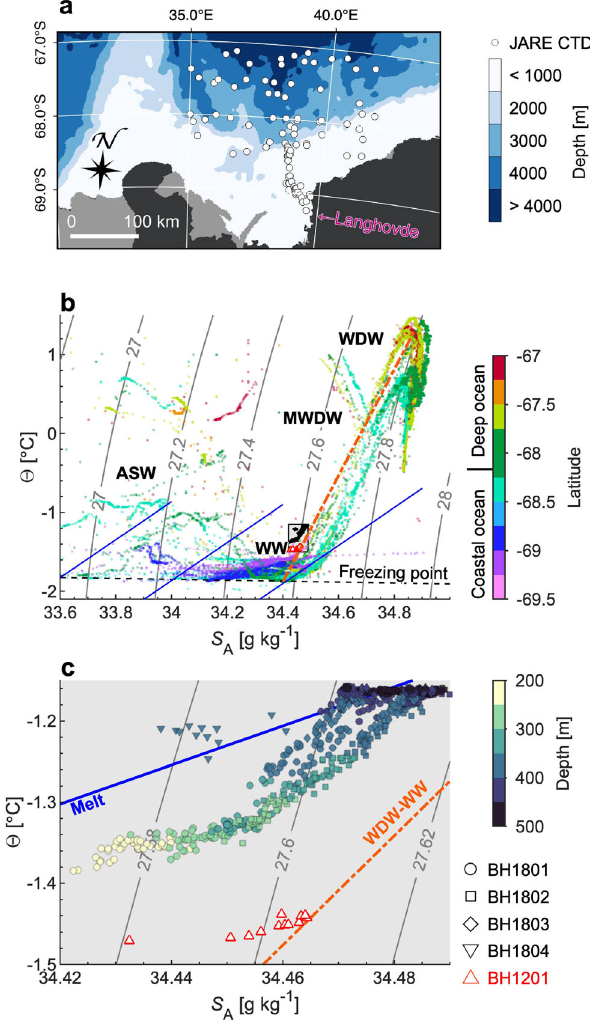
Fig. 5 Ocean and subshelf water properties. a Locations of the CTD casts (white circles) previously performed by the Japanese Antarctica Research Expedition. The background bedrock topography is from the IBCSO bathymetry 48 . b Conservative temperature-absolute salinity diagram, showing water properties previously reported in the nearby ocean, and those obtained beneath the ice shelf of Langhovde Glacier in this study (black dot) and January 2012 at BH1804 (red triangle) 23 . Locations of the CTD casts in the ocean are indicated in Fig. 5a. Also indicated are the meltwater-mixing line 44,45 (thick solid blue; gradient of 2.41°C/(g kg − 1 )), isopycnals (gray), freezing point (dashed black) referenced surface pressure, and the WDW-WW mixing line (dash-dotted orange). The box bounding the subshelf measurements indicates the region enlarged in ( c ). c Conservative temperature and absolute salinity obtained by subshelf measurements in this study. Marker color represents the depth of the measurement. See Supplementary Fig. 4 for more details of the water properties near the ice – ocean boundary. WDW: Warm Deep Water, MWDW: Modi fi ed Warm Deep Water, WW: Winter Water, and ASW: Antarctic Surface